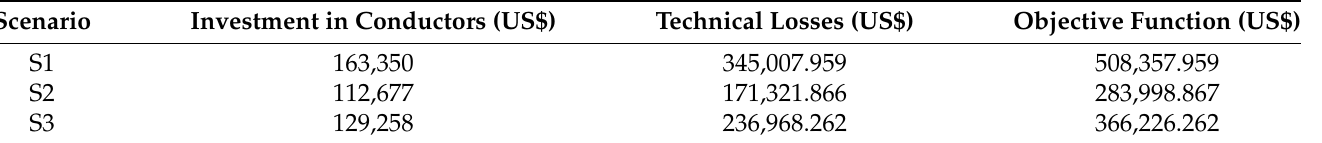
Table 12. Investment and operating costs in the 8-bus test system for the balanced load case. Scenario